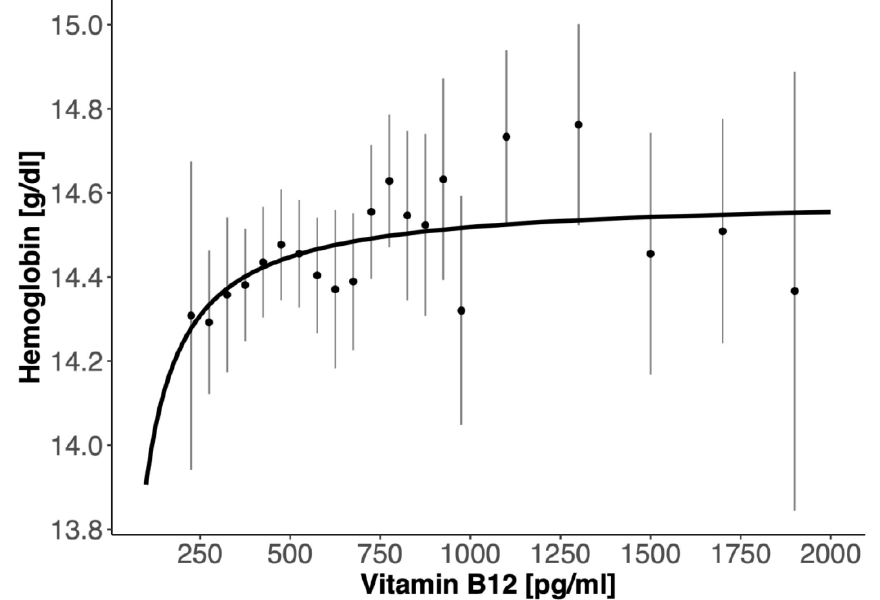
Figure 2. The fitted saturation curve for hemoglobin used to calculate the threshold value for the 99% saturation. 99%